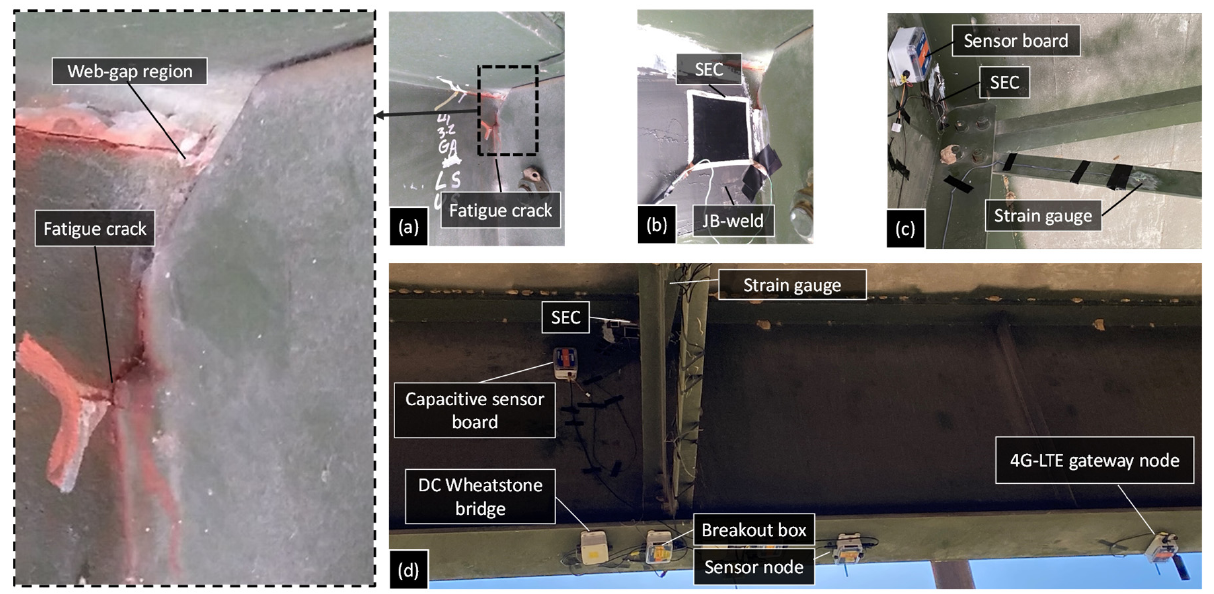
Figure 12. Installation of the proposed WLASS: ( a ) figure crack, ( b ) SEC, ( c ) strain gauge, and ( d ) installation of the WLASS.